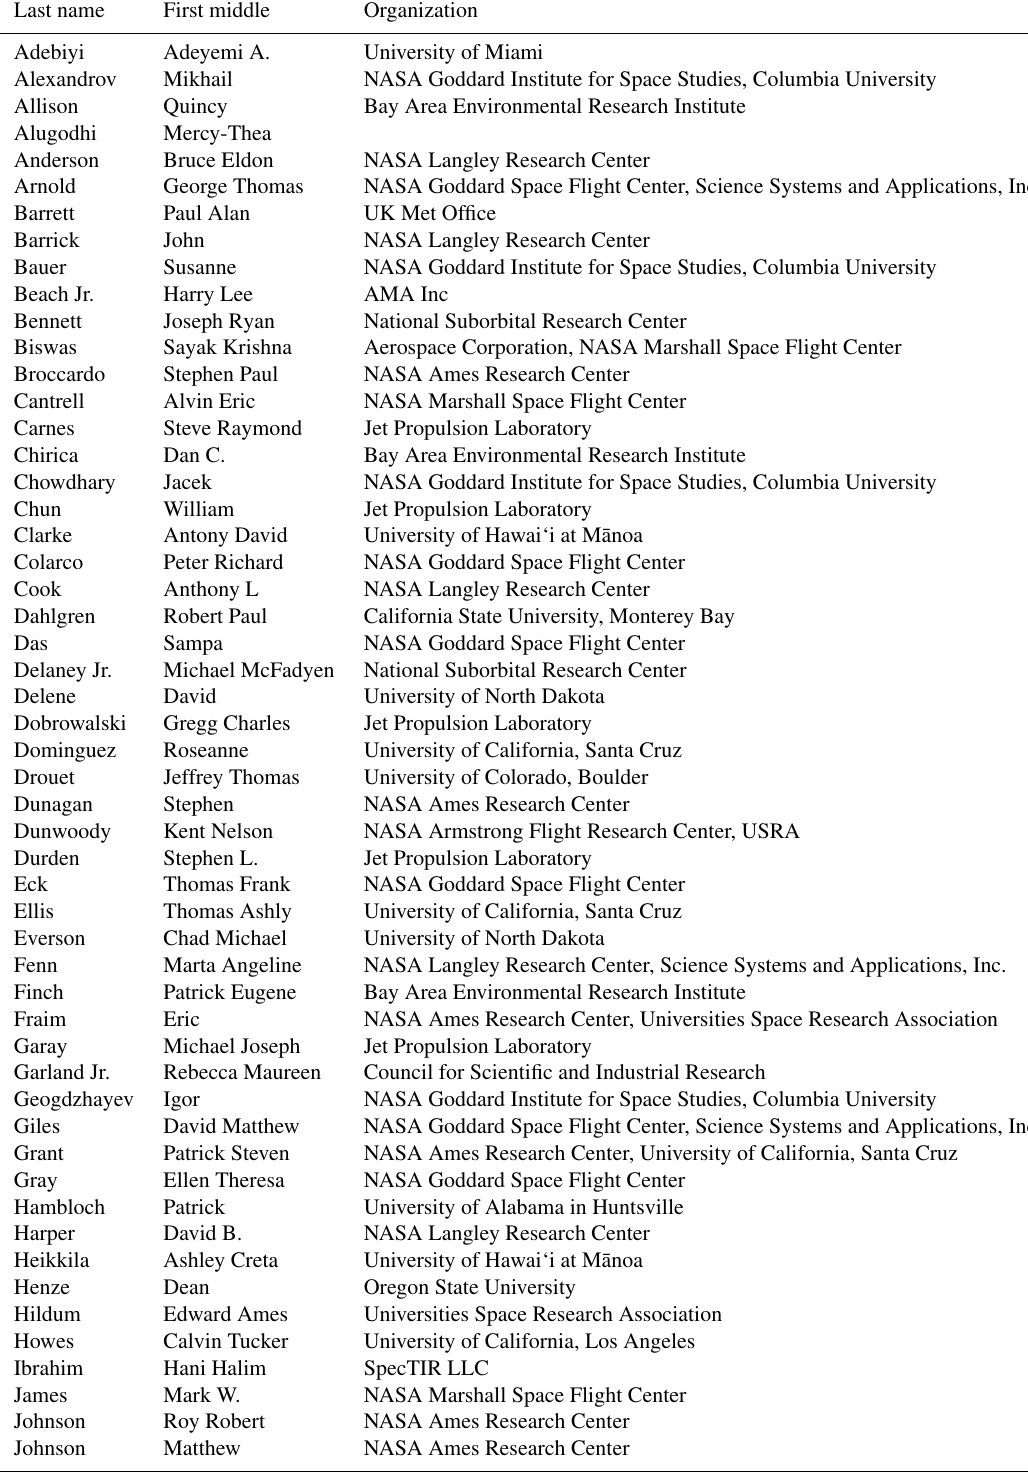
Table C1. Participants in the ORACLES project, 2014–2019, not co-authoring this